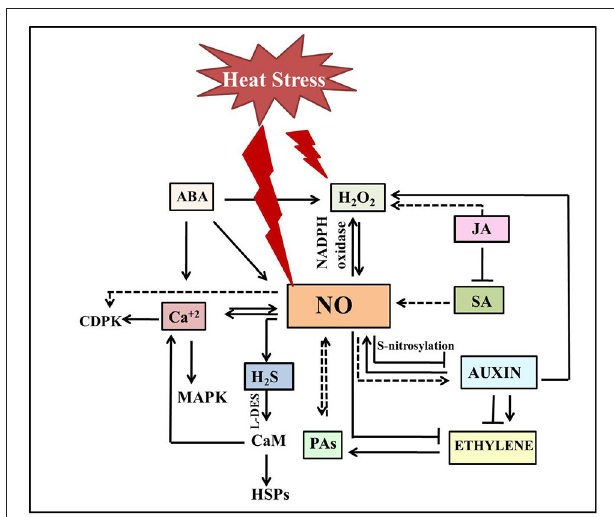
FIGURE 2 | Schematic illustration depicting cross talk of NO with other signaling molecules under heat stress. Heat stress triggers NO accumulation which in turn either stimulates (normal end arrow) or inhibits (blunt end arrow) hormone-mediated heat stress signaling. NO mostly acts downstream to phytohormones under heat stress. Plant heat tolerance not just include crosstalk between H 2 O 2 , NO, and H 2 S, but also involve activation of Ca 2 + channels, and Ca 2 + -CaM-dependent protein phosphatase along with other factors to induce DNA-binding activity of the heat shock factors and subsequent accumulation of HSPs. The dotted line denotes the pathways not studied clearly. The double-sided arrow indicates the mutual regulation of molecules. ABA, Abscisic acid; Ca 2 + , calcium ion; CaM, calmodulin; CDPK, calcium dependent protein kinase; H 2 O 2 , hydrogen peroxide; HSPs, heat shock proteins; H 2 S, Hydrogen sufide; JA, jasmonic acid; MAPK, mitogen activated protein kinase; NO, nitric oxide; SA, salicylic acid; PAs,